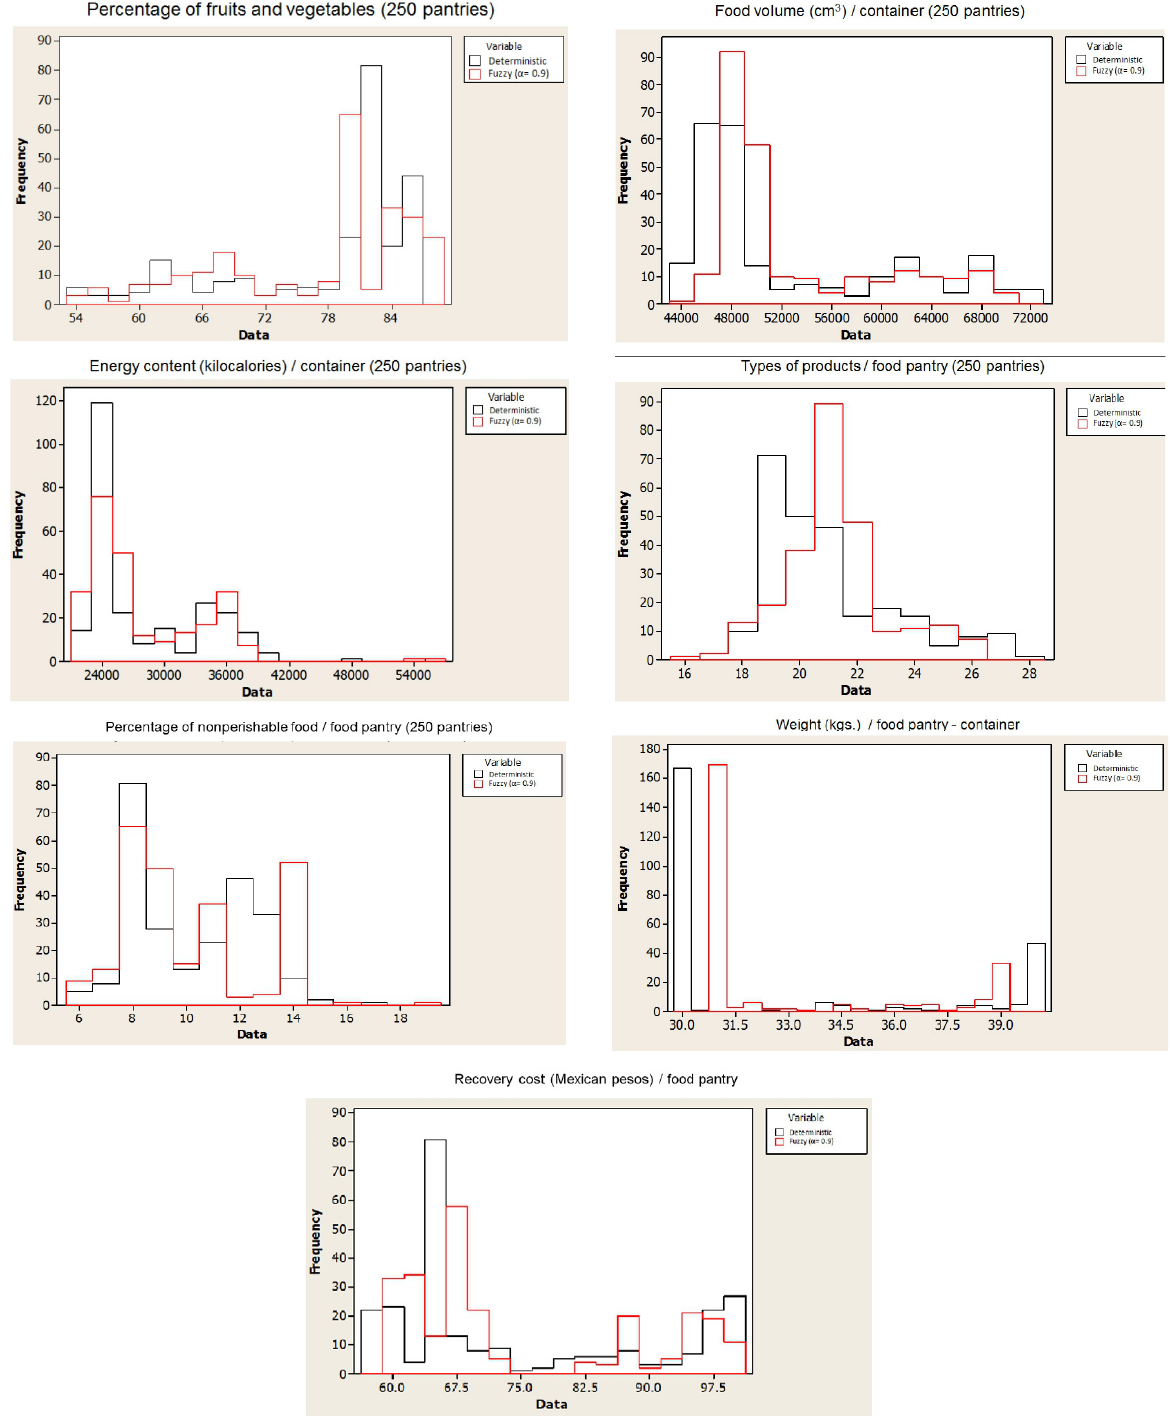
Figure 7. Comparative analysis between deterministic model and fuzzy model ( α = 0.9) per